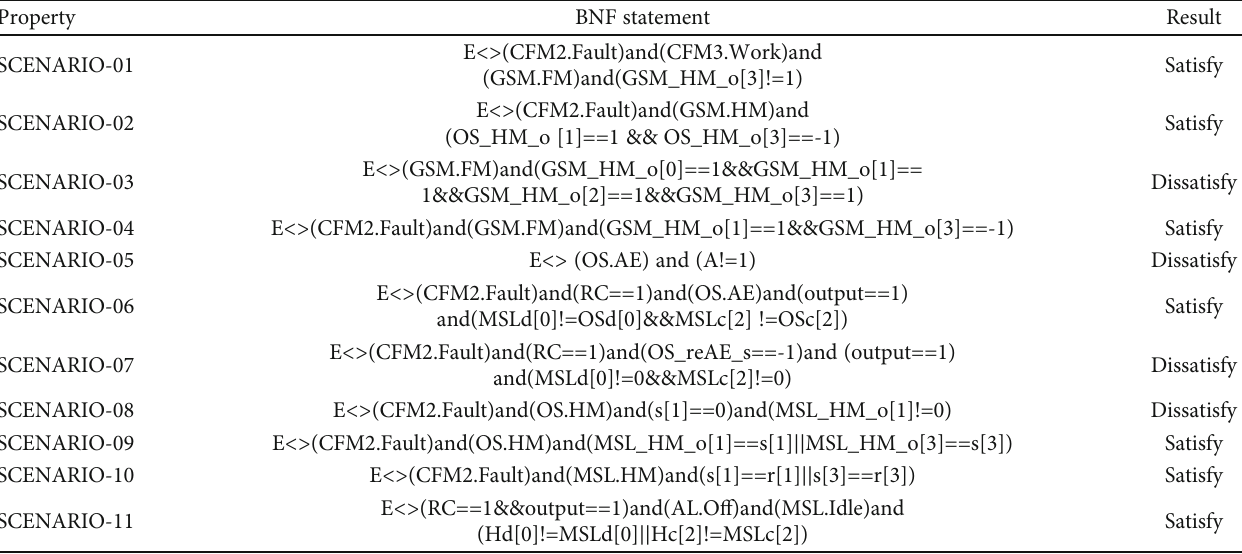
Figure 8: Loss scenario analysis framework. Table 5: SCENARIO veri fi cation